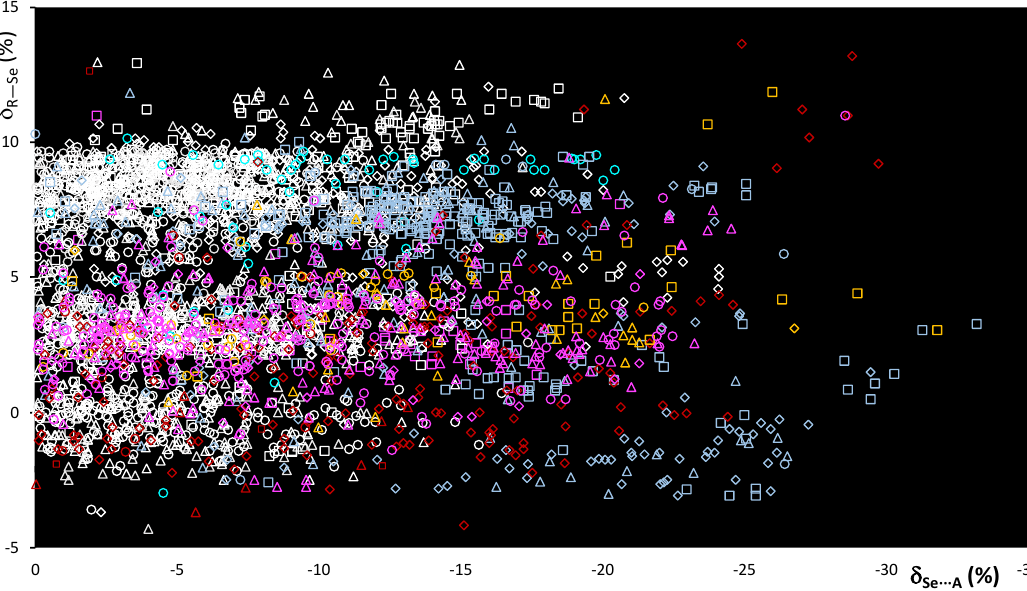
Figure 6. Scatterplot of the δ R – Se vs. δ Se···A functions calculated for fragments R – Se···A. R = C (white), O (red), N (light blue), S (yellow), and Se (magenta); A = N (square), Ch (circle), O (rhomb), and Ha (triangle).